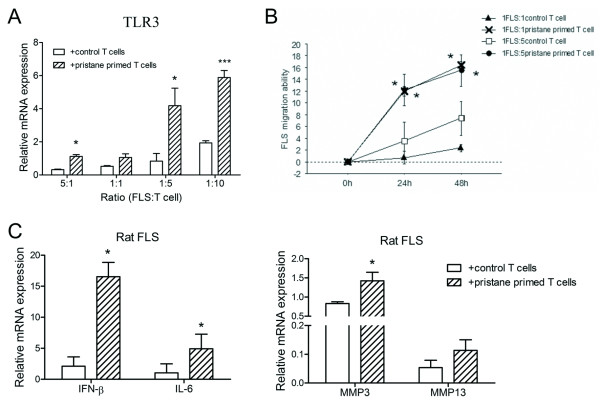
Functional analysis of rat FLSs co-cultured with pristane-primed T cells. Rat FLSs were co-cultured with pristane-primed or control T cells, and relative mRNA expression of genes in FLSs was detected by real-time PCR. (A) TLR3 mRNA expression in FLSs was measured 24 hours after co-culture with series FLS:T-cell ratios of 5:1, 1:1, 1:5 and 1:10. (B) FLS migration ability was analyzed 24 and 48 hours after co-culture with FLS:T-cell ratios of 1:1 and 1:5. The migration ability of FLSs co-cultured with pristane-primed T cells was compared to that co-cultured with control T cells. (C) Cytokine (IFN-β and IL-6) and matrix metalloproteinase MMP3 and MMP13 expression were detected 24 hours after co-culture with the cell ratio 1:10. Their expression in FLSs co-cultured with pristane-primed T cells was compared to that co-cultured with control T cells. Data are presented as means ± SEM of four replicated determinations from three independent experiments. Levels of significance were calculated by using Student's t-test (*P < 0.05, ***P < 0.001).